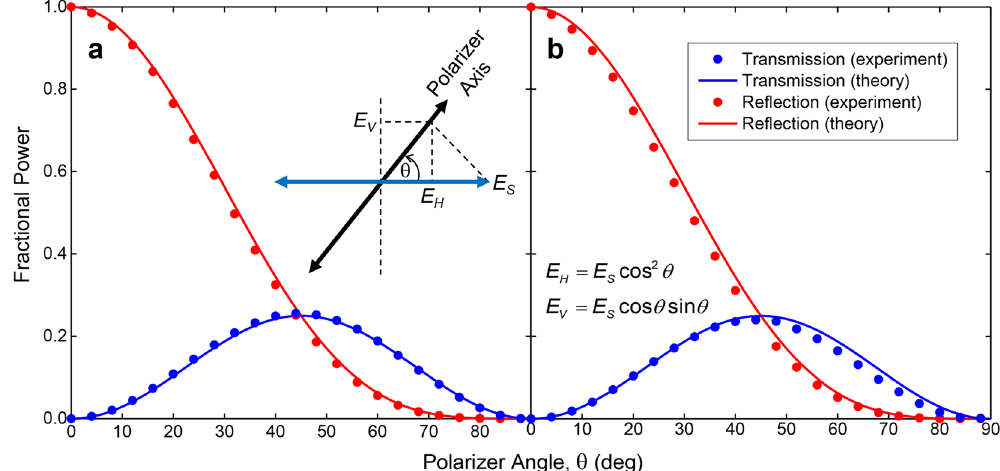
Figure 5. Fractional power division. Results are shown for the frequencies of ( a ) 0.2 THz, and ( b ) 0.5 THz, as a function of the input-polarizer angle. The dots give the experimental values and the solid curves give the theoretical values. The red curves correspond to the reflection arm (horizontal polarization) and the blue curves correspond to the transmission arm (vertical polarization). The inset cartoon shows the respective directions of the input-side polarizer axis and the transmitter electric-field ( E S ) polarization that is fixed, and the consequent horizontal ( E H ) and vertical ( E V ) components of the electric field as a function of the polarizer